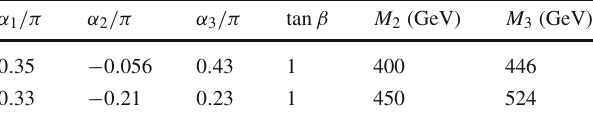
Table 5 Suggested points selected from the allowed parameter space [121]. Note that M 3 is not an independent parameter. Furthermore, μ